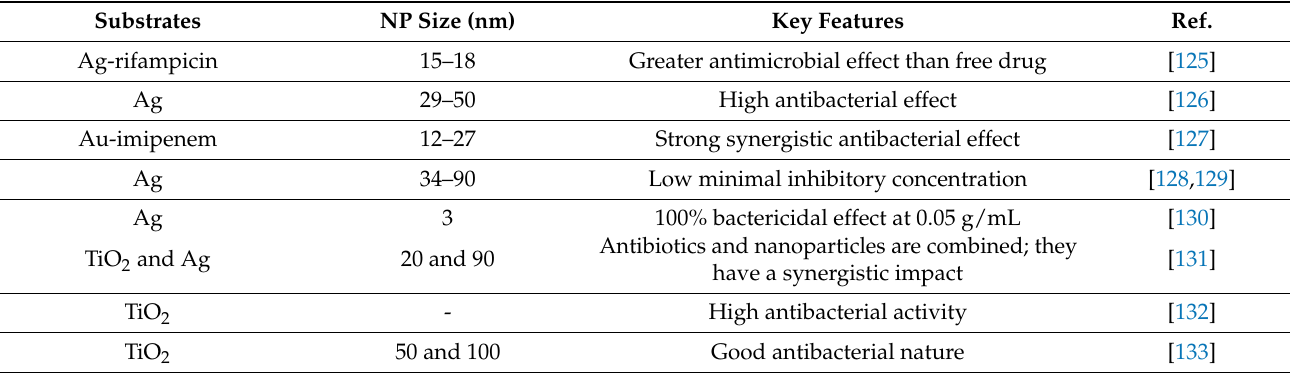
Table 3. Nanostructures that have been used to treat K. pneumoniae –related infectious. Key